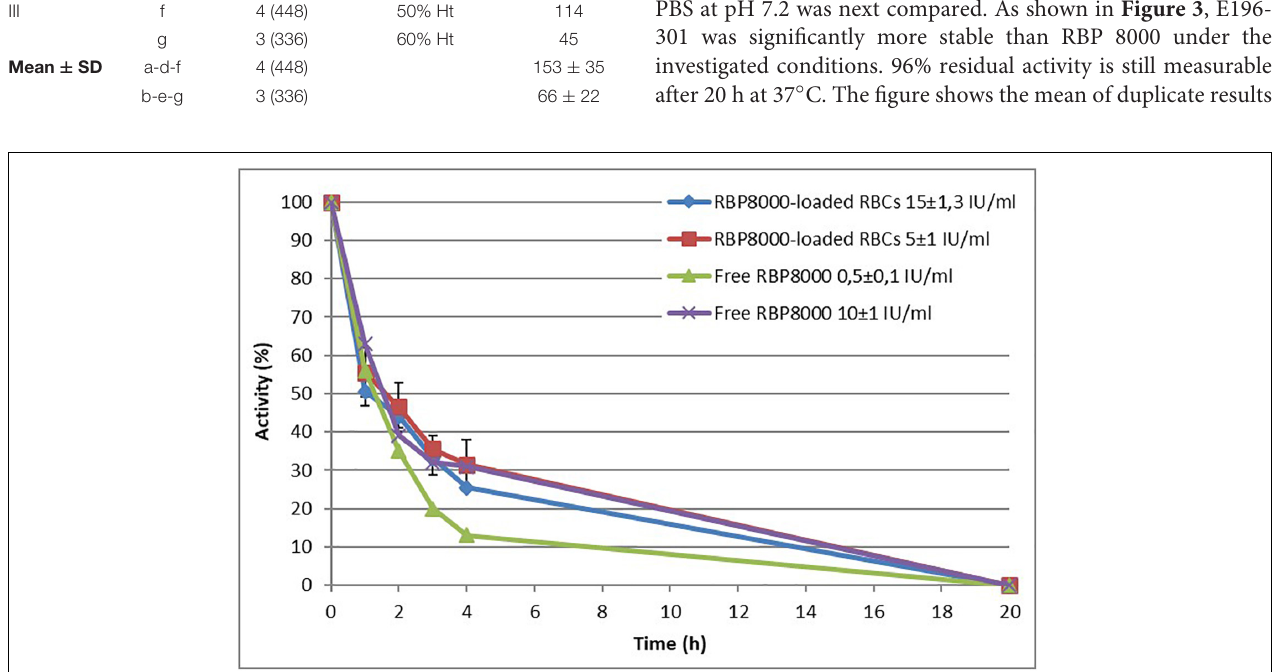
FIGURE 2 | RBP 8000 stability. In vitro stability of free and red blood cell (RBC)-loaded RBP 8000 at 37 ◦ C in PBS, pH 7.2. Free enzyme was tested at 0.5 ± 0.1 and 10 ± 1 IU/ml. RBC-loaded enzyme was tested at 5 ± 1 and 15 ± 1.3 IU/ml RBCs. RBC suspensions at 10% Ht were used. All experiments were in duplicate that agree within 7.5%. Results are mean ± SD of three different experiments. Values of RBP 8000-loaded RBCs were not significantly different from control (free RBP 8000 at 10 ± 1 U/ml).